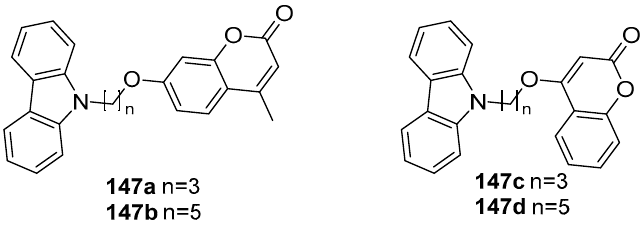
Figure 45. Chemical structure of compounds 147a–d .